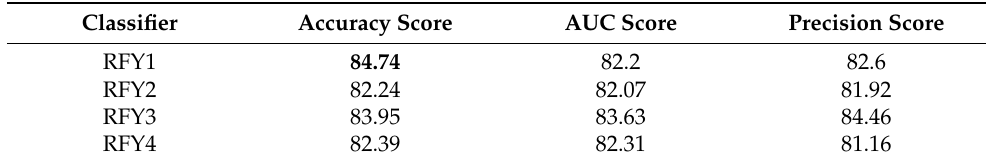
Figure 16. Random forest AUC variation across different year gaps. Table 4. Temporal accuracy assessment of RF.